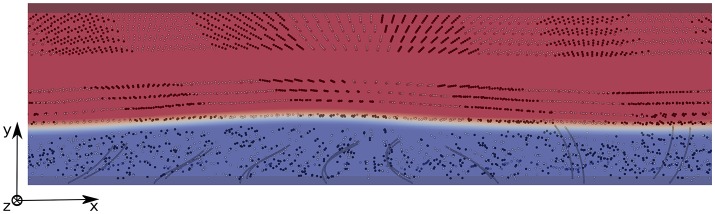
3D view of the domain filled with 3 populations of tracers for Re = 5.10−2, 60 beating cycles after their release at t = t0 when the flow is fully-established. The tracers in the PCL are significantly mixed, while the tracers in areas 2 and 3 still present coherent patterns.